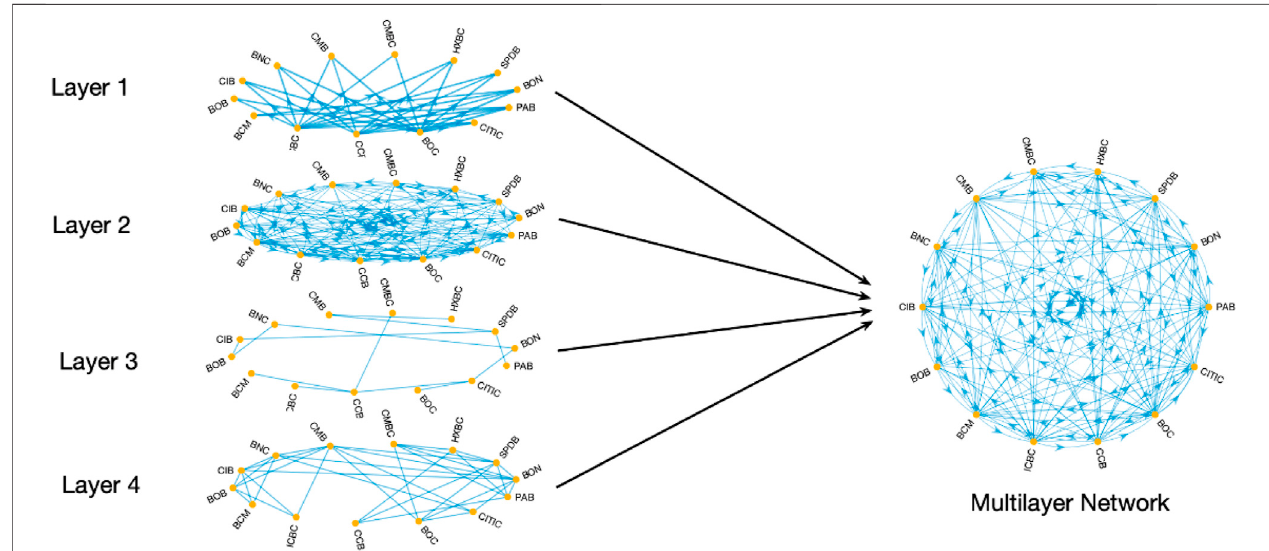
FIGURE 4 | Four layers of the risk correlation